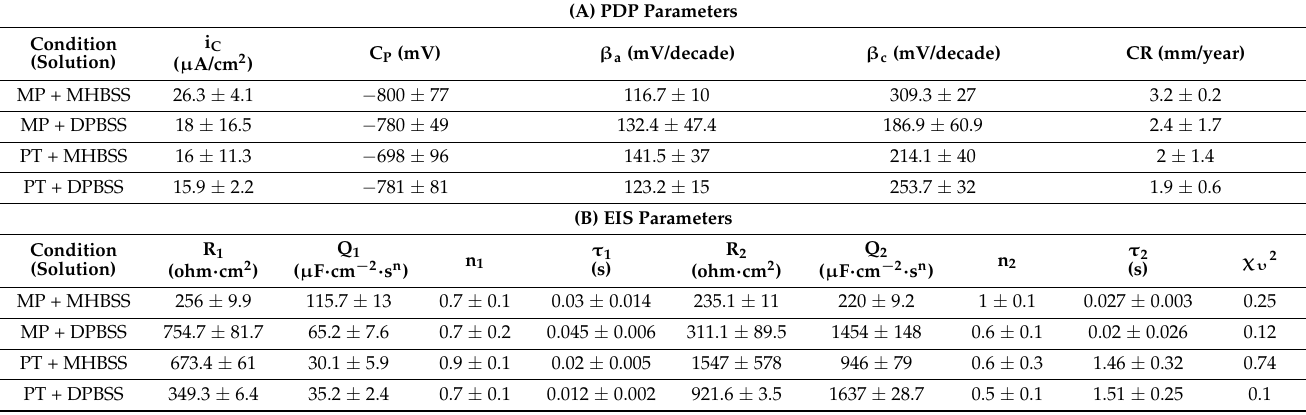
Figure 4. Electrochemical test results of the investigated conditions in MHBSS and DPBSS: ( a ) potentiodynamic polarization tests (inset shows the open circuit potential evaluation); ( b ) Nyquist diagram and the fitted model (lines); ( c , d ) Bode diagram of the samples with the fitted model (lines) (inset in ( d ) shows the equivalent circuit for the studied conditions). Time constants 1 and 2 are indicted by the arrows in low (1 Hz) and middle (100 Hz) frequencies. Table 4. Electrochemical corrosion parameters derived from PDP ( A ) and EIS results ( B ). The meanings of the symbols are the following one: i C : corrosion current density; C P : corrosion potential; β a : anodic tafel constant; β c : cathodic tafel constant; CR: corrosion rate; R 1 : resistance of the porous outer oxide layer; Q 1 : capacitance of the porous outer oxide layer; n 1 : coefficient of Q 1 ; R 2 : resistance value associated to the inner oxide/nitride layer; Q 2 : capacitance of the inner oxide/nitride layer; n 2 : coefficient of Q 2 ; χ υ 2 : reduced χ 2 .